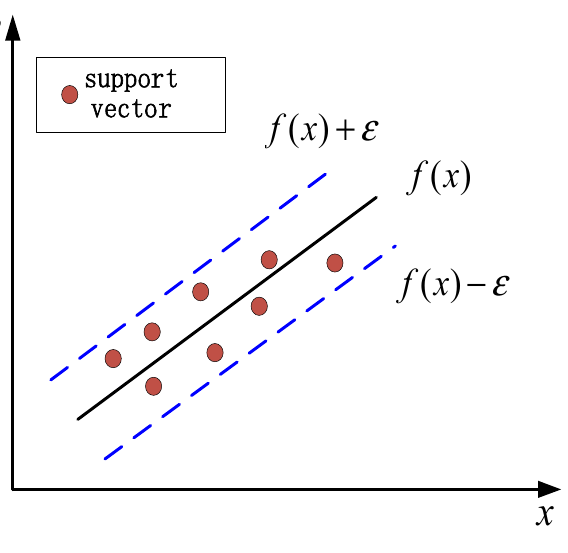
Figure 4. Schematic diagram of the basic idea of SVR . For training sample